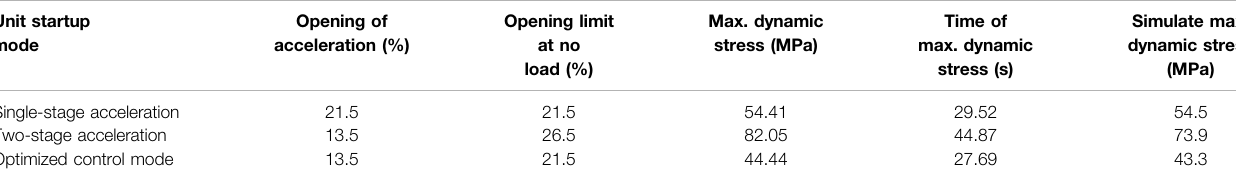
TABLE 1 | The governor parameter, max. dynamic stress test, and simulation